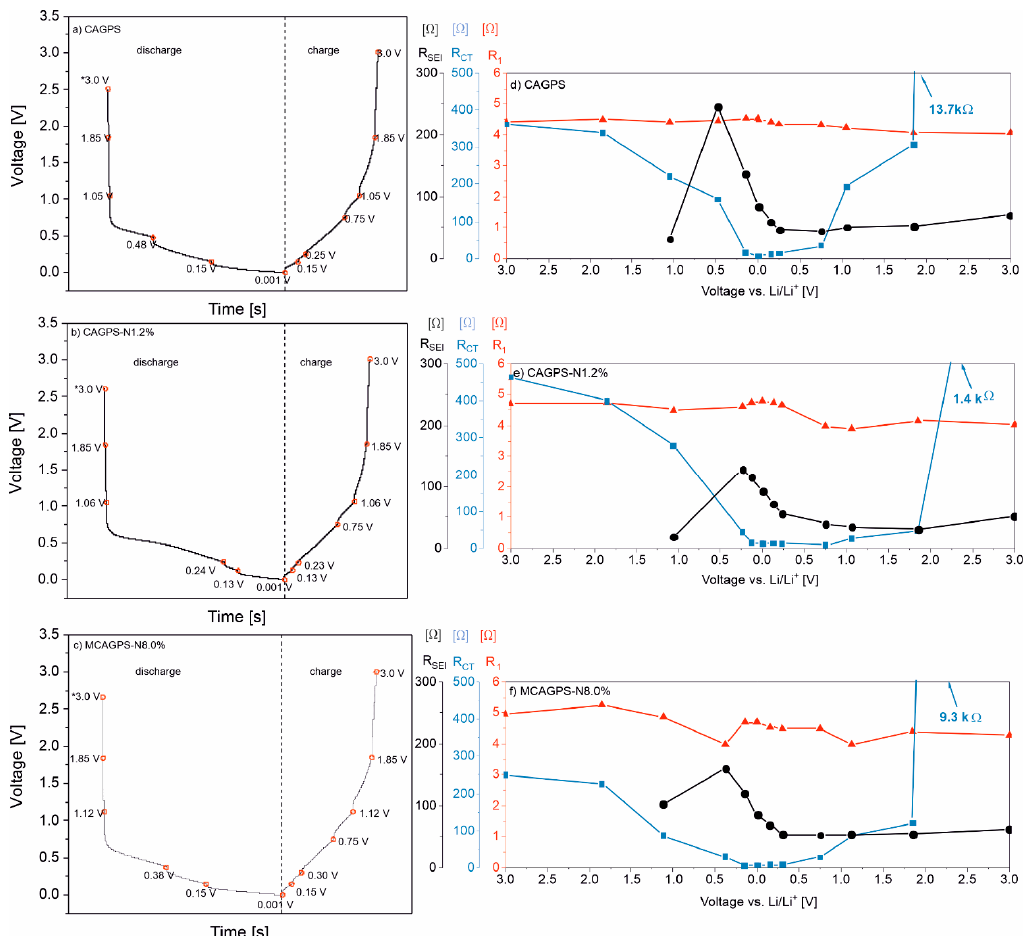
Figure 6. Voltage profiles of ( a ) CAGPS, ( b ) CAGPS-N1.2%, and ( c ) MCAGPS-N8.0% materials with marked potentials, in which electrochemical impedance spectroscopy (EIS) measurements were carried out. The values of R 1 , R SEI , and R CT as functions of potential for ( d ) CAGPS, ( e ) CAGPS-N1.2%, and ( f ) MCAGPS-N8.0%, respectively ((MCAGPS—carbon aerogel made from potato starch modified with melamine; CAGPS-N—carbon aerogel made from potato starch modified by N 2 pyrolysis; CAGPS—pristine carbon